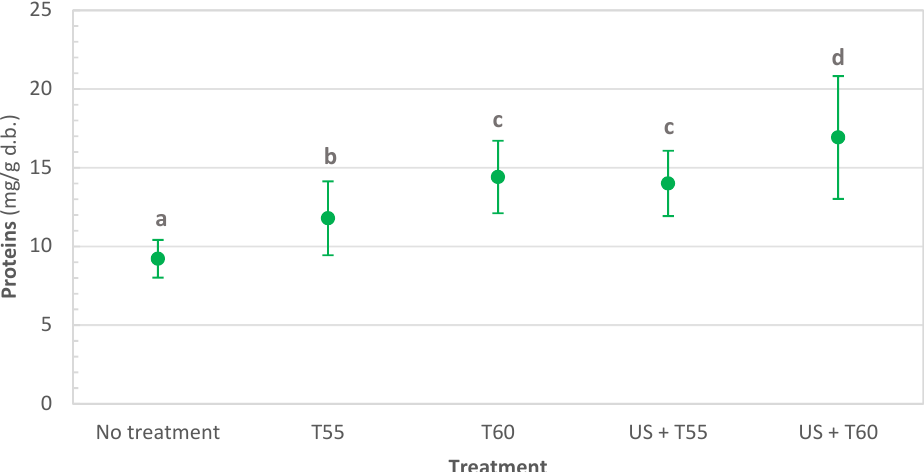
Figure 1. Protein content in untreated, thermally treated and thermosonicated kiwi peel. Values with different letters differ significantly ( p < 0.01 ).